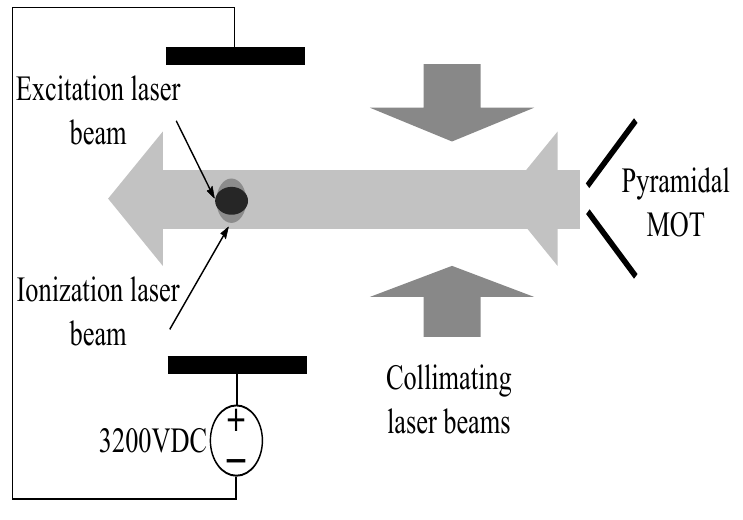
Figure 3. Schematic diagram of the experimental setup for the production and excitation of a cold Cs atom